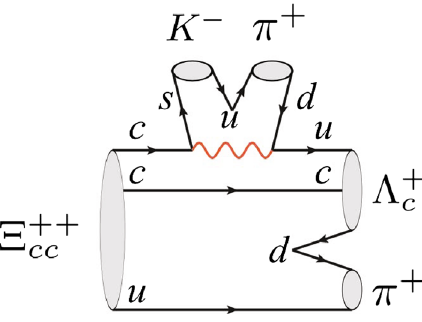
Fig. 4 Dominant diagram of (cid:4) ++ cc → (cid:2) + c K − π + π